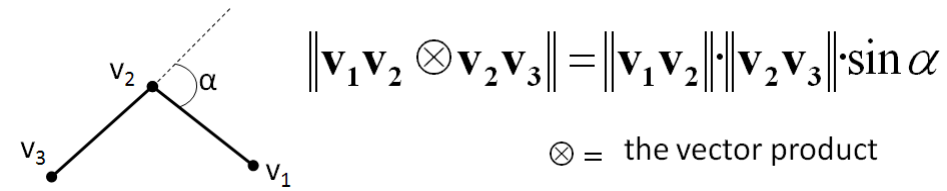
Figure 6. Expression of the curvature preservation constraint.